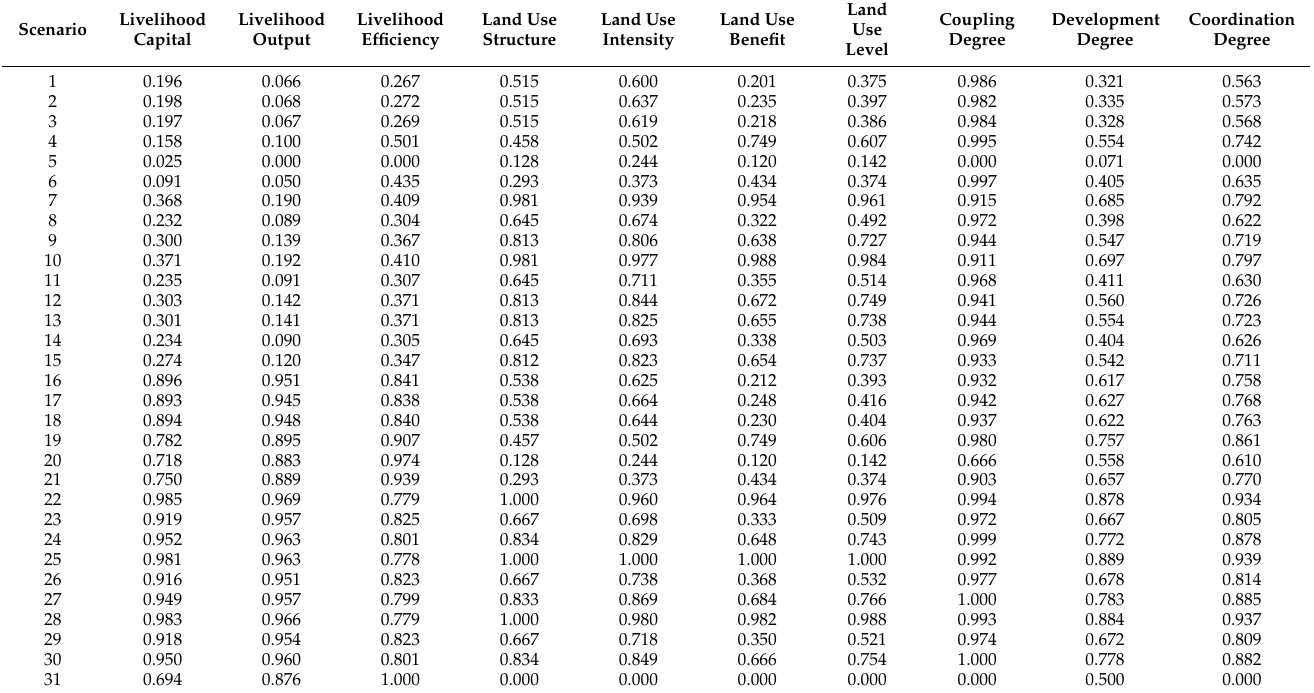
Table 6. Farmers’ livelihood and land use under different scenarios.